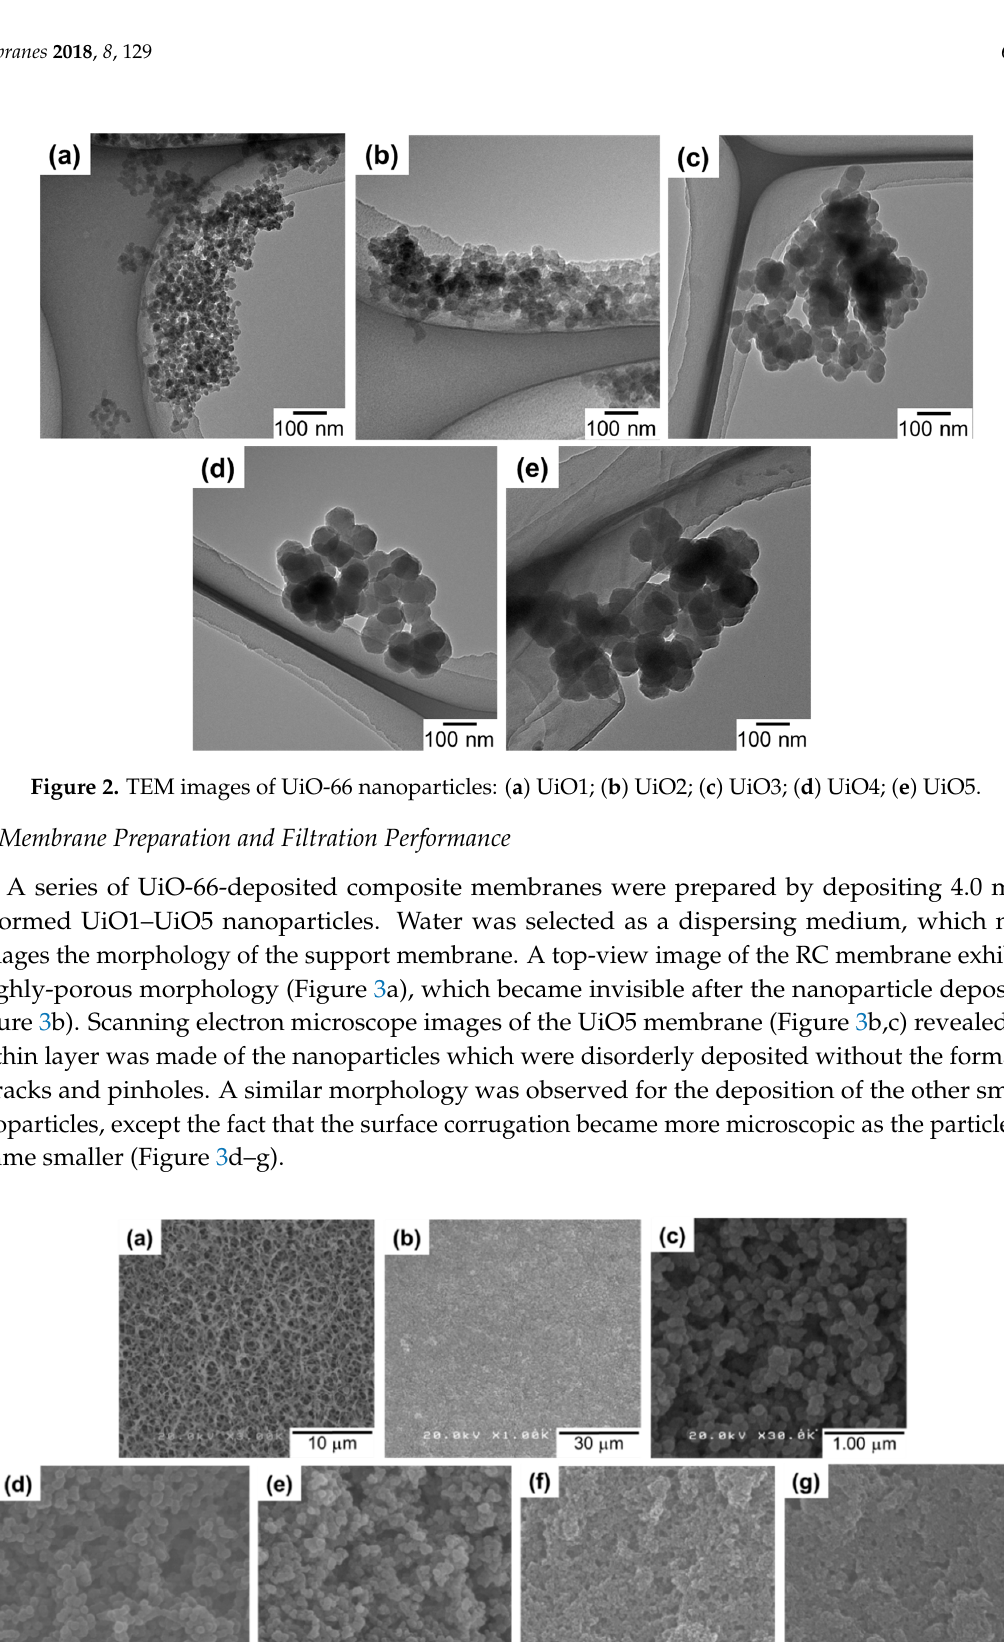
Figure 3. Top-view SEM images of the composite membranes: ( a ) a regenerated cellulose substrate; ( b , c ) UiO5 at different magnifications; ( d ) UiO4; ( e ) UiO3; ( f ) UiO2; ( g ) UiO1.